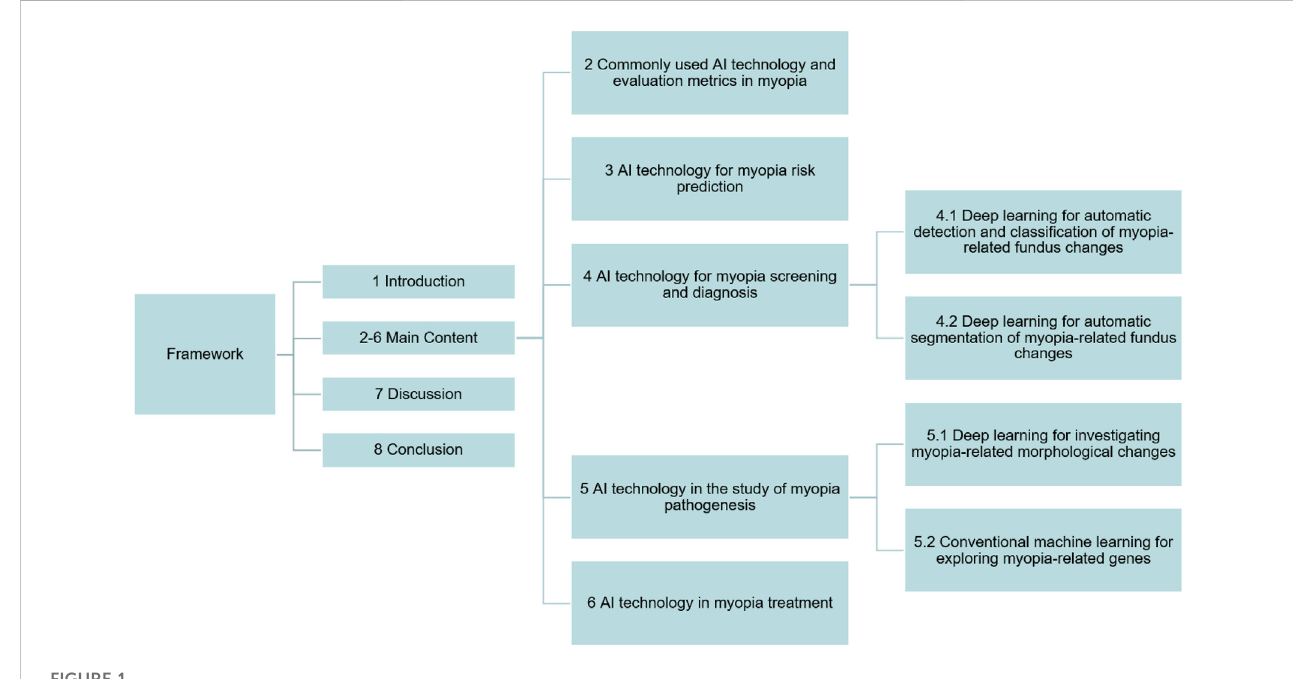
FIGURE 1 Overview diagram of this